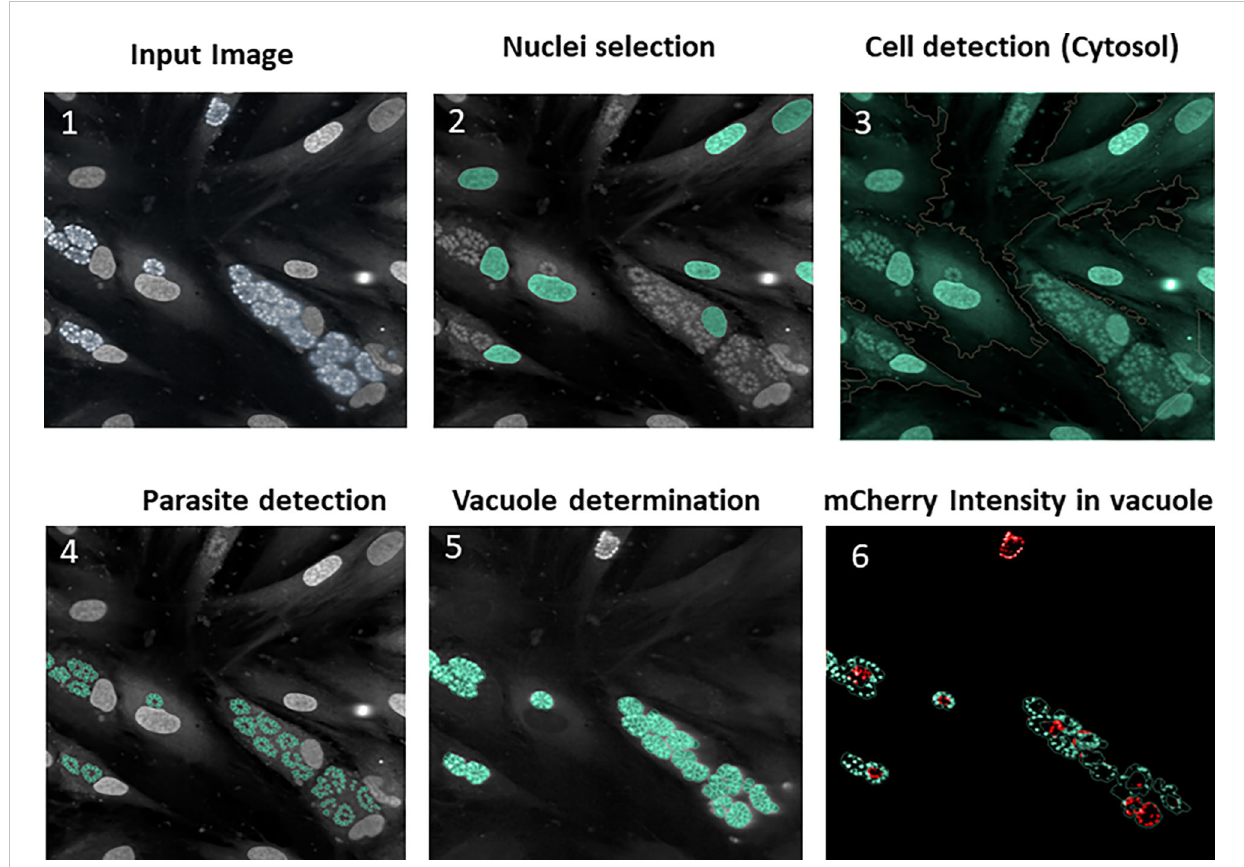
FIGURE 3 Typical images and image analysis work fl ow (described in detail in the Columbus analysis script): (1) Raw image acquisition from the reader; (2) Segmentation on the blue channel to detect the HFF nuclei (stained with DAPI reagent), followed by false detection removal based on the intensity/ morphology properties in order to retain true nuclei only; (3) HFF cytosol delimitation around nuclei using prede fi ned algorithm based on the use of the DAPI channel, which also stains cytosol (producing a signal of lower intensity); 4) Parasite detection within the cytosol region allowing the DAPI- labeled plots to be segmented into parasite nuclei; (5) Vacuole determination by the total proximal parasites nuclei area (as parasites grow in the vacuole the nucleus area can be mathematically expanded around them); (6) mCherry intensity, enabling determination of disrupted vacuoles. In order for a vacuole to be considered as positive, the mean of the mCherry fl uorescence intensity should not be too high and the ratio of mCherry intensity between the vacuole center and the periphery must exceed